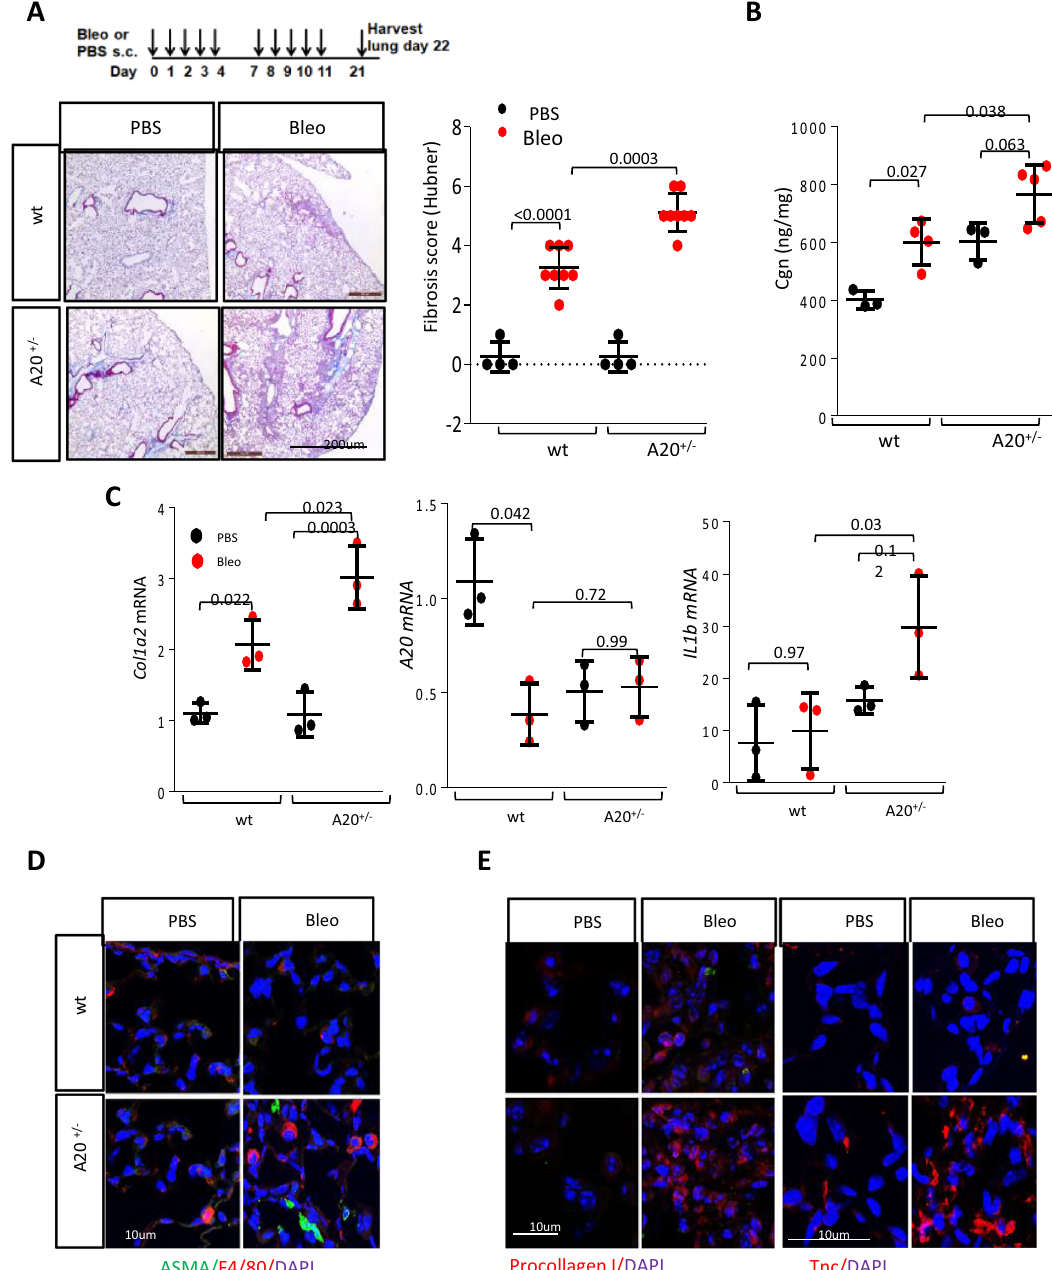
Fig. 3 | A20 +/ − mice showed exaggerated lung fi brosis. Control A20 fl / fl (wt) mice and A20 +/ − mice in parallel were treated with s.c. bleomycin (10mg/kg) or PBS for 2 weeks, and lungs were harvested at day 22. A Top: schematic of the experiment. Left panel: Trichrome stains. Representative images; size bars=200 µ m. Right panel: lung fi brosis scores (Hubner); results are mean±SD One-way ANOVA fol- lowed by Sidak ’ s multiple comparison test (PBS-treated, n =3; bleo-treated, wt, n =4, KO, n =5). B Lung collagen content: each dot represents the mean±SD of